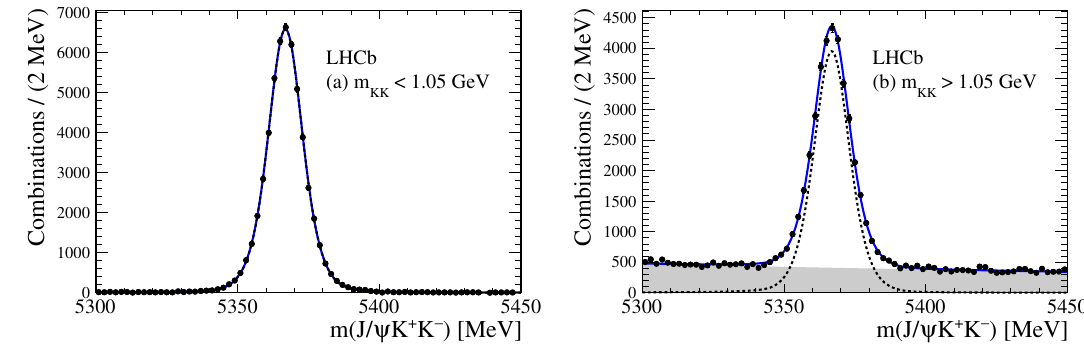
Figure 2 . Fits to invariant mass distributions of J= K + K (cid:0) combinations after subtraction of the two re(cid:13)ection backgrounds for (a) m KK < 1 : 05 GeV and (b) m KK > 1 : 05 GeV. Total (cid:12)ts are shown by solid (blue) lines, the signal by dashed (black) lines, and the combinatorial background by darkened regions. Note that the combinatorial background in (a) is too small to be easily